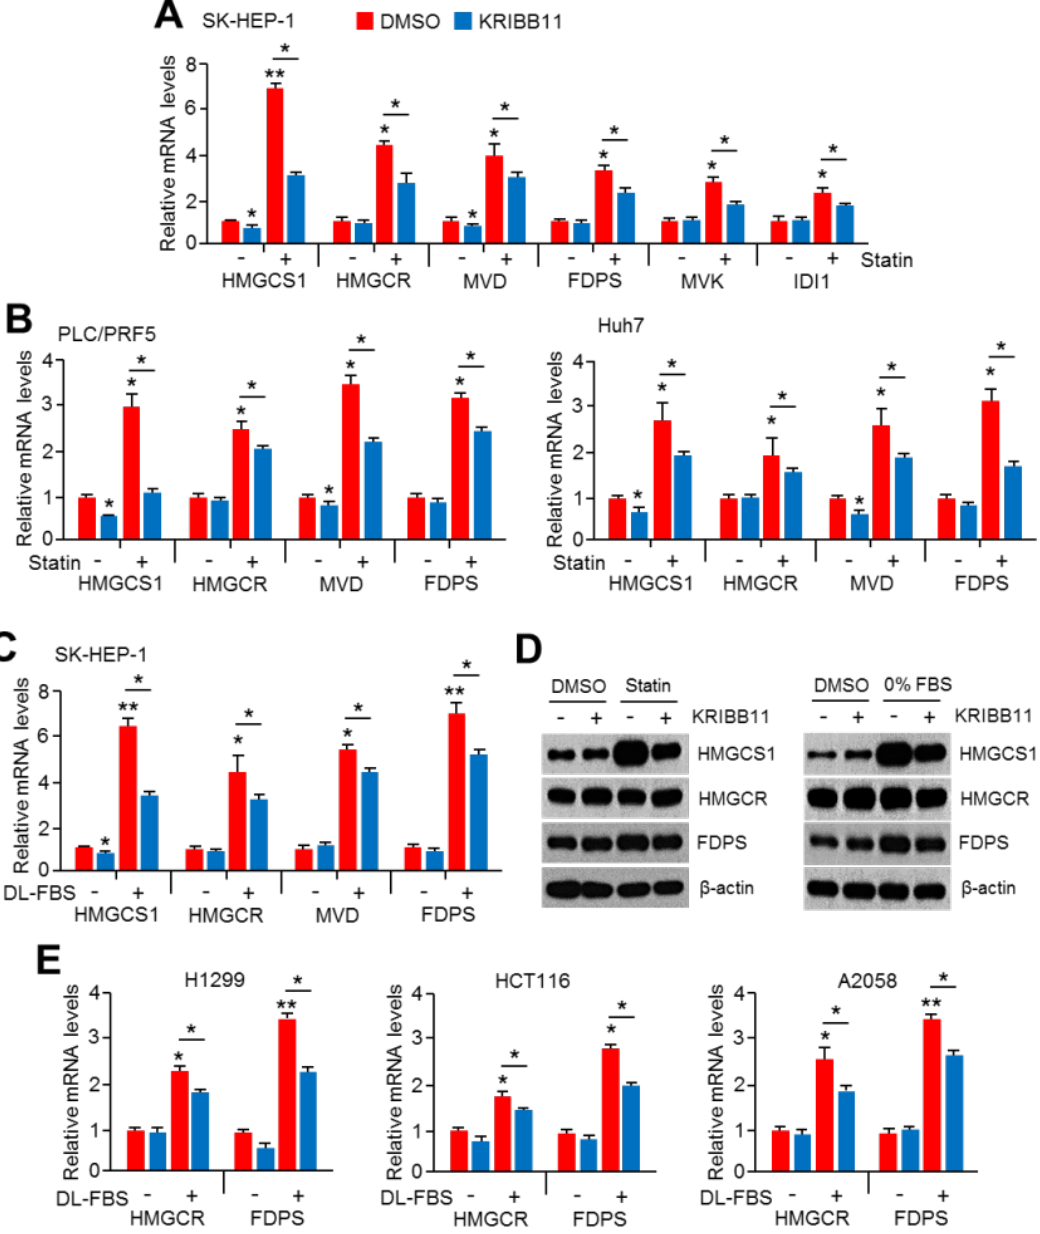
Figure 1. KRIBB11 attenuated mevalonate and cholesterol biosynthesis-related gene expression in hepatocellular carcinoma (HCC) cells. ( A , B ) SK-HEP-1, PLC / PRF5, and Huh7 cells were pretreated with KRIBB11 (2 µ M) for 1 h and further treated with simvastatin (10 µ M) for 24 h. The mRNA levels were measured using quantitative real-time polymerase chain reaction (qRT-PCR). The values represent the mean ± SD of two independent experiments performed in triplicate. ( C ) SK-HEP-1 cells were cultured in lipoprotein-depleted fetal bovine serum (DL-FBS) for 6 h, and then cells were further incubated with KRIBB11 (2 µ M) for 24 h. The mRNA levels were measured using qRT-PCR. The values represent the mean ± SD of two independent experiments performed in triplicate. ( D ) SK-HEP-1 cells were incubated under simvastatin (10 µ M) treatment or DL-FBS for 1 h or 6 h, respectively, and then KRIBB11 was further incubated for 24 h. The expression of proteins was measured by western blotting. ( E ) H1299, HCT116, and A2058 cells were cultured in lipoprotein-depleted fetal bovine serum (DL-FBS) for 6 h, and then cells were further incubated with KRIBB11 (2 µ M) for 24 h. The mRNA levels were measured using qRT-PCR. The values represent the mean ± SD of two independent experiments performed in triplicate. * p < 0.05 and ** p < 0.01.